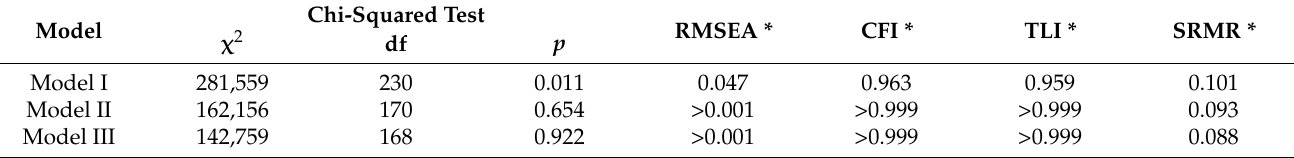
Table 4. Results of fit